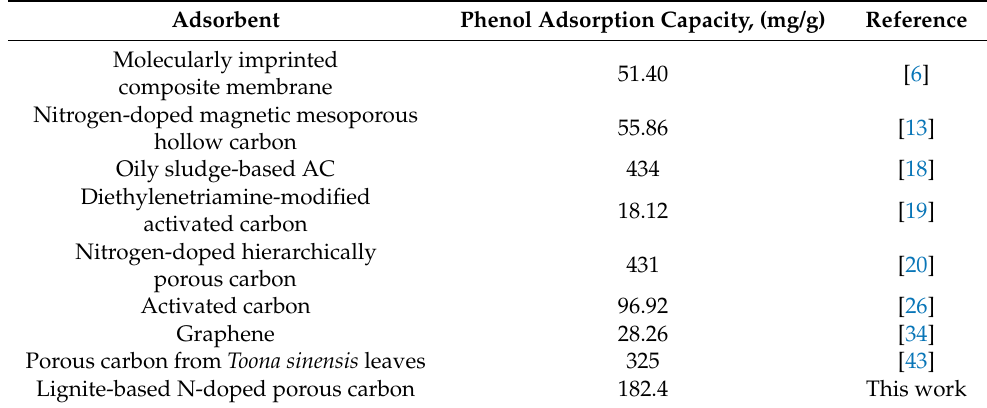
Figure 7. Effect of activation temperature on the adsorption capacities of L-x ( a ) and L-CN-x ( b ) samples. Adsorption conditions: C 0 = 133 mg/L, m / v = 0.4 g/L, 20 °C, t = 90 min. Table 4. Phenol adsorption capacity of adsorbents in some recent reports.